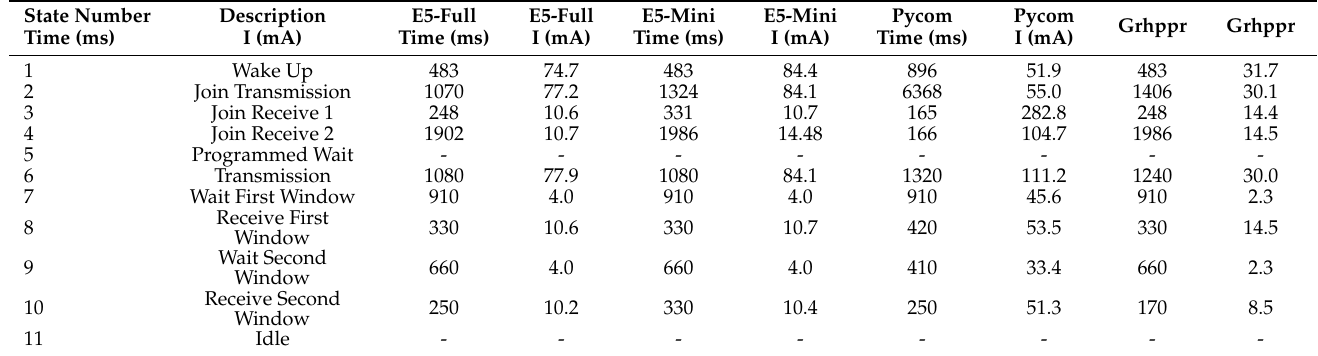
Table 5. Identified Power Profile Stages and Numerical Results.